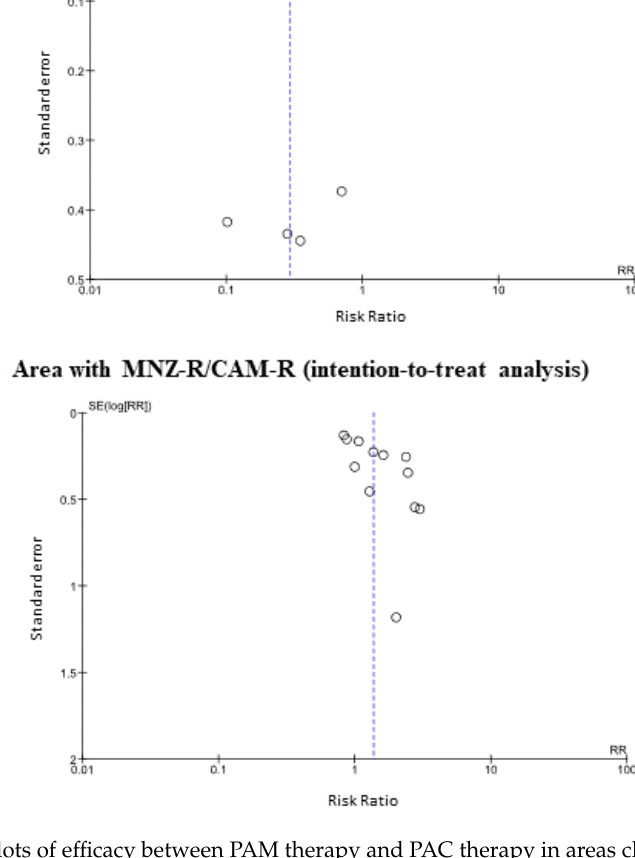
Figure 5. Funnel plots of efficacy between PAM therapy and PAC therapy in areas classified as having ( A ) low CAM resistance (< 15%) and high MNZ resistance ( ≥ 15%), ( B ) high CAM resistance and low MNZ resistance, and ( C ) high CAM resistance and high MNZ resistance in intention-to-treat analysis. Abbreviations: CAM, clarithromycin; MNZ, metronidazole; PAC, proton pup inhibitor (PPI)/amoxicillin/clarithromycin; PAM, PPI/amoxicillin/metronidazole; RR, risk ratio; SE, standard error.